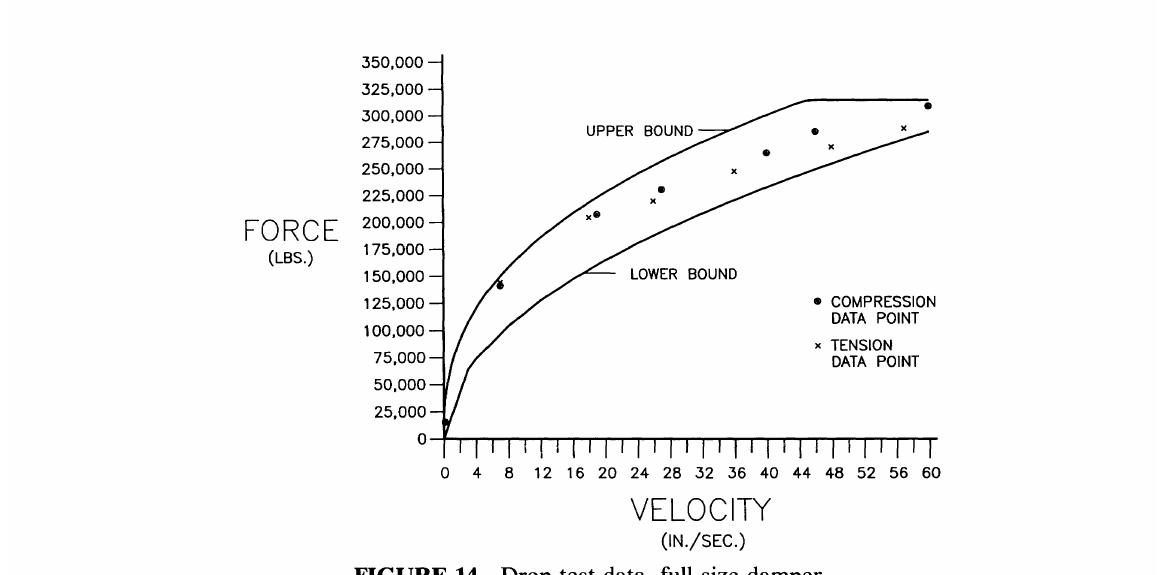
FIGURE 14 Drop test data, full size